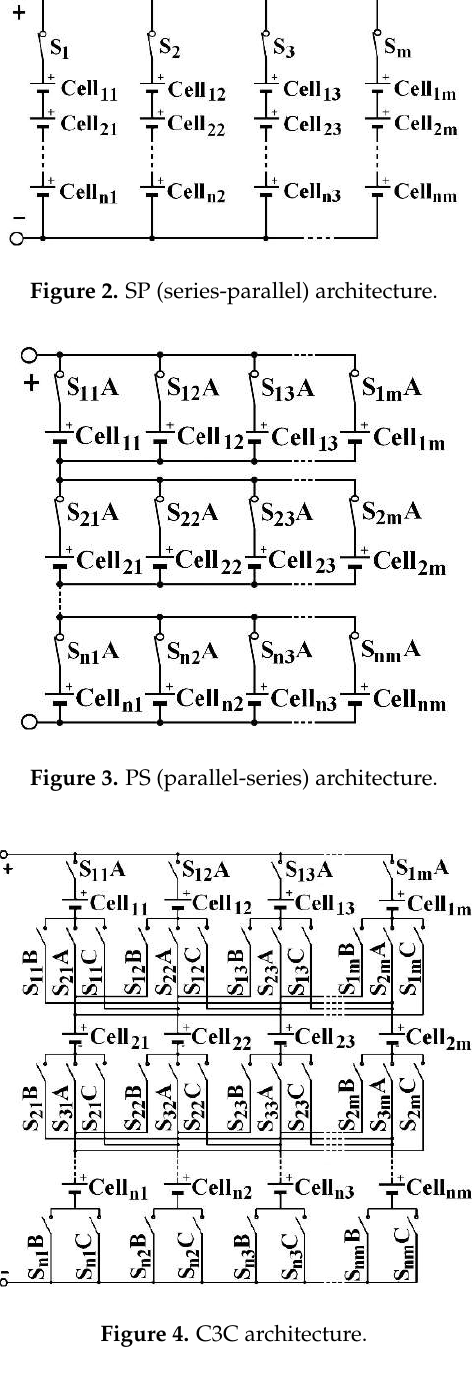
Figure 4. C3C architecture. Figure 5. C3C element.